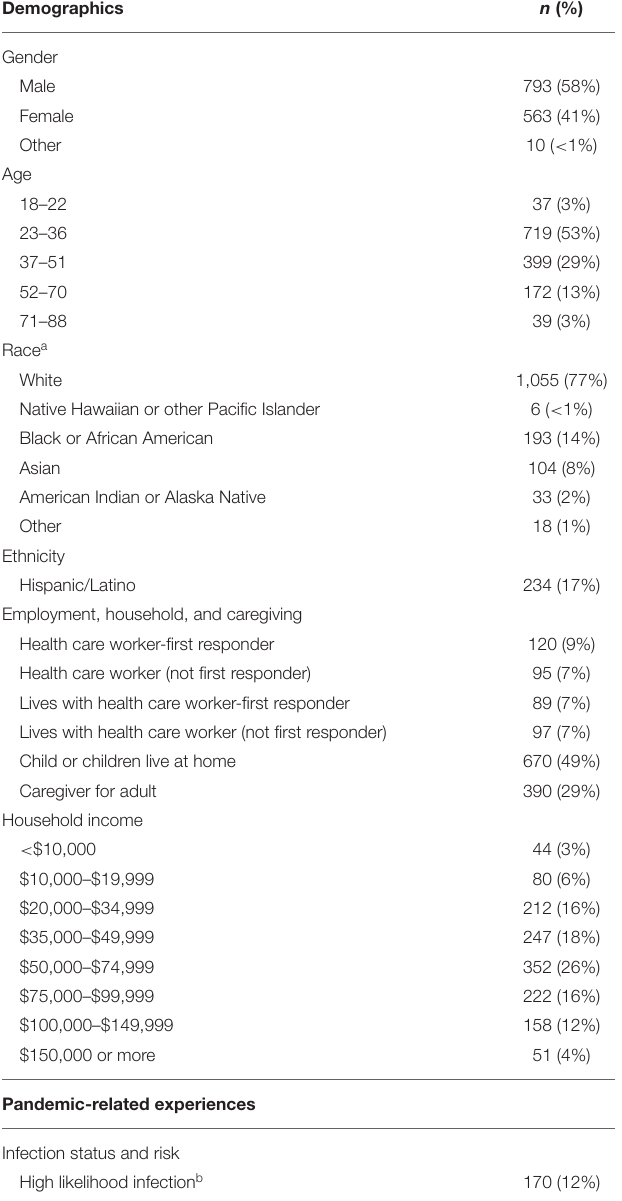
TABLE 1 | Respondent demographics and pandemic-related experiences ( N = 1,366).